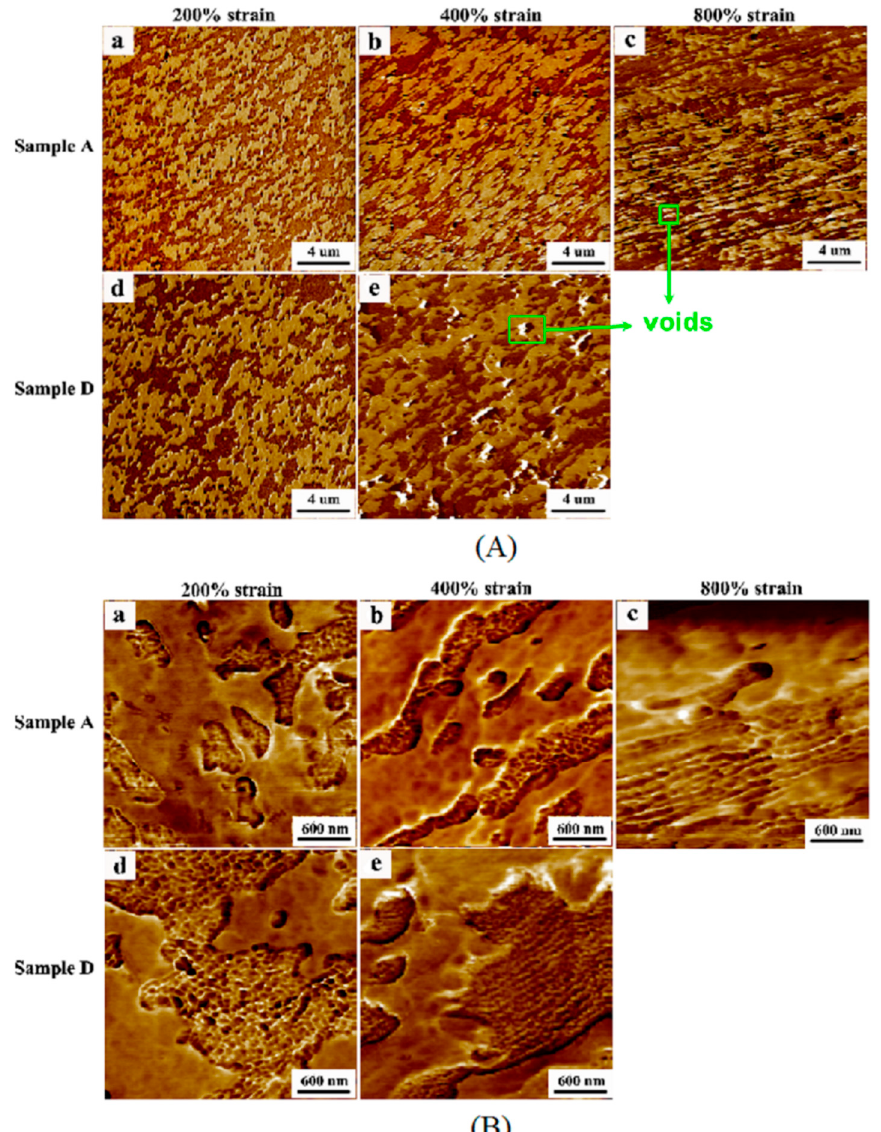
Figure 7. AFM images of elongated samples at different tensile strains (The darker and lighter regions represent the EPDM and PP phases, respectively.): ( A ) Low magnification; ( B ) high magnification. a, b, c are the AFM images of Samples A with strain of 200%, 400%, 800%, respectively; d and e are the AFM images of Samples D with strain of 200% and 400%, respectively.